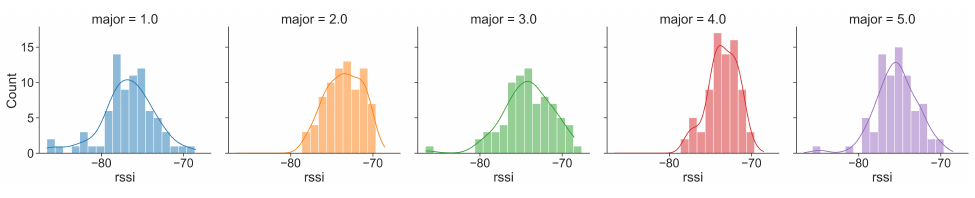
Figure 12. Distributions of beacon’s RSS for T 8 for each tag.